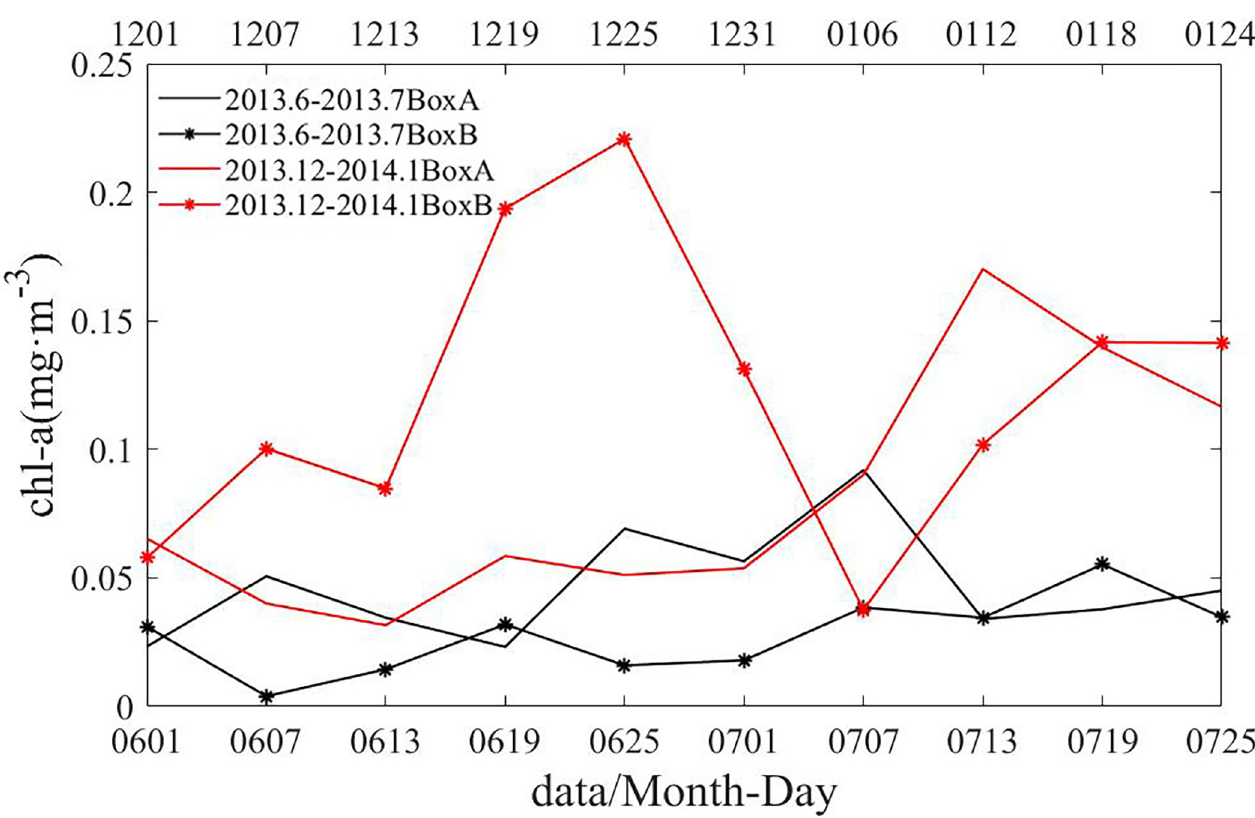
Fig 3. Chl-a concentration in Boxes A and B in June and July 2013 (black line) and December 2013 and January 2014 (red line).